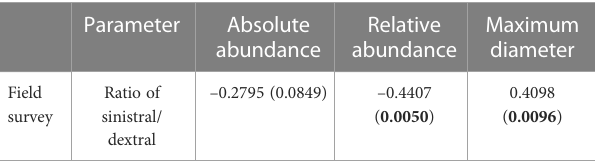
TABLE 3 Correlations (Pearson ’ s r values) between the ratio of sinistral/ dextral and other biotic parameters of A . aomoriensis in the fi eld survey.